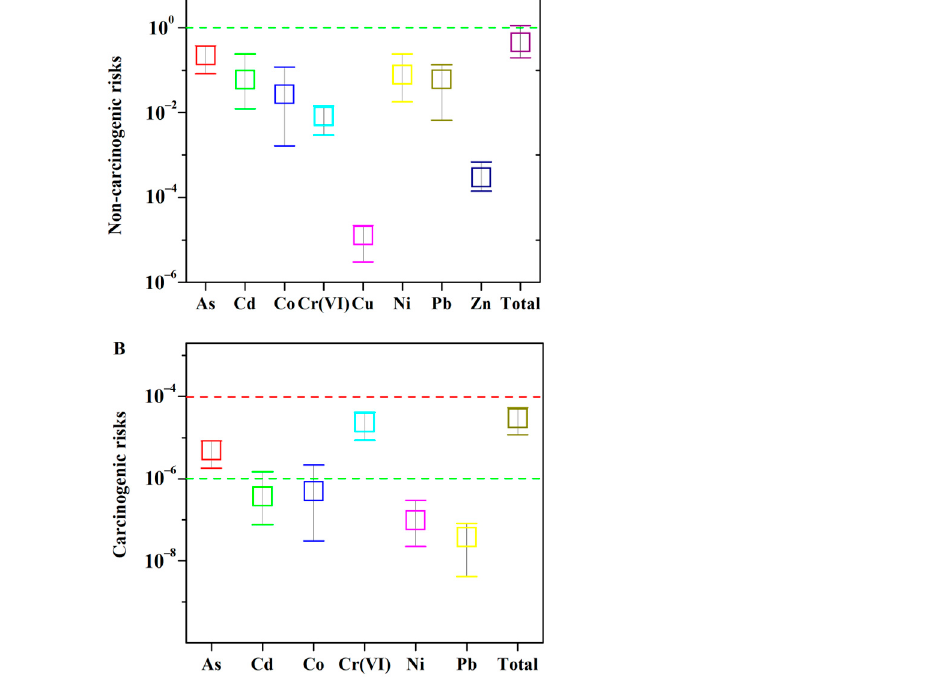
Figure 5. Non-carcinogenic ( A ) and carcinogenic ( B ) risks of exposure to PM 2.5 -bound metals estimated via the inhalation route in Yuci College Town, Shanxi, China ( n = 34).